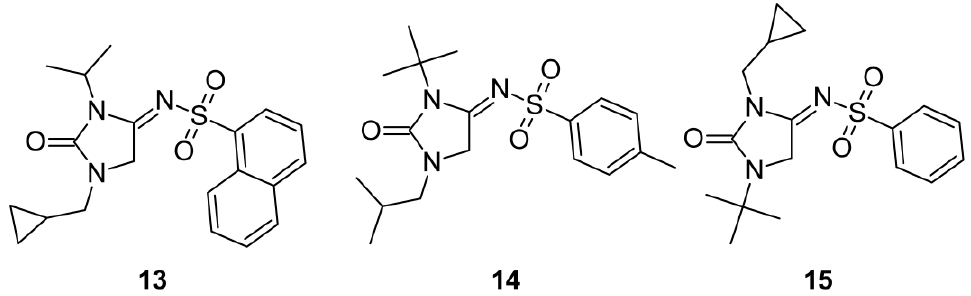
Figure 3. Chemical structure of compounds 13 – 15 .